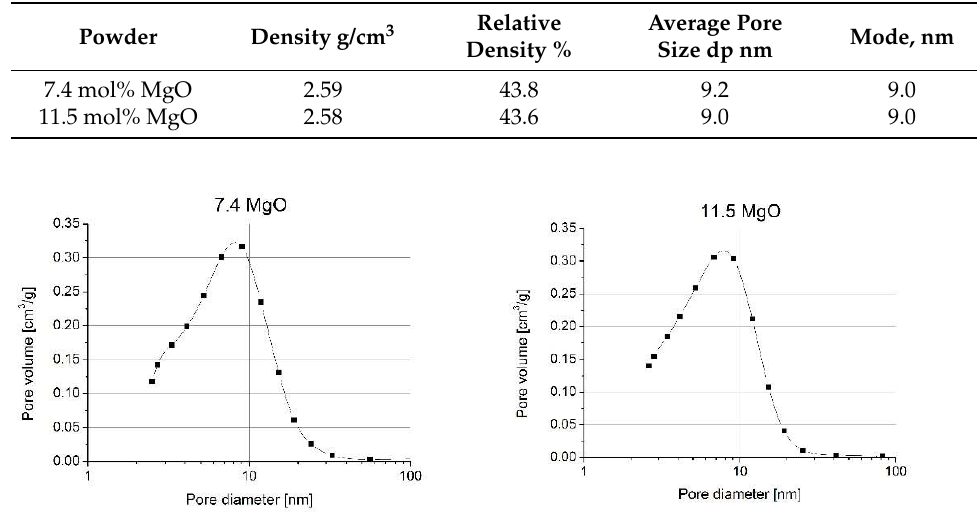
Figure 3. Pore size distribution (dV/dlogd) in the 7.4 mol% and 11.5 mol% MgO powder compacts.